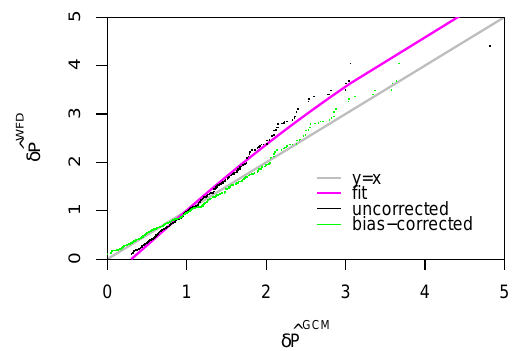
Fig. 6. Rank ordered normalised observational and simulated pre- cipitation values of all wet April days during the reference period for the example grid cell (black). The associated regression curve (red) and the bias-corrected normalised data (green) are presented in addition. The identity line x = y is shown in